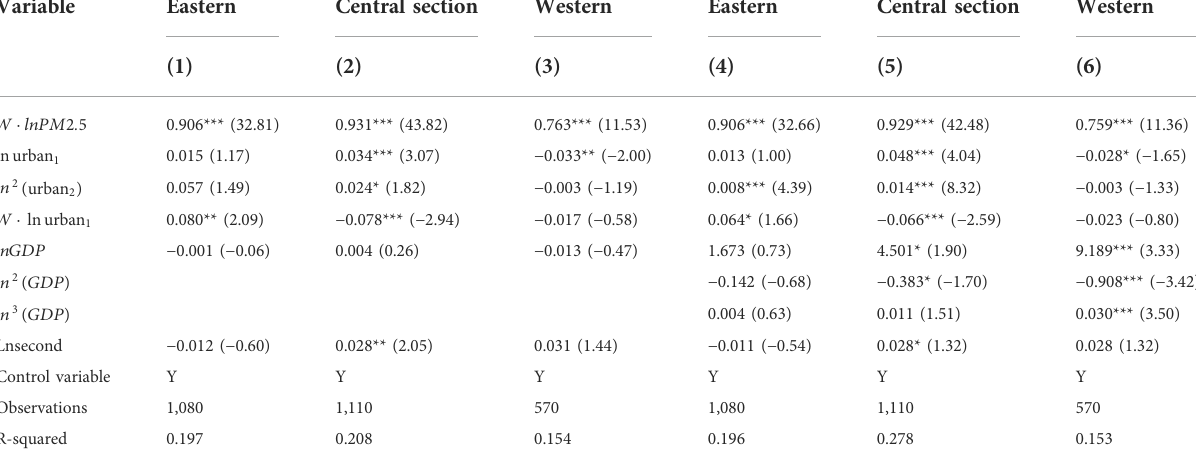
TABLE 8 Heterogeneity